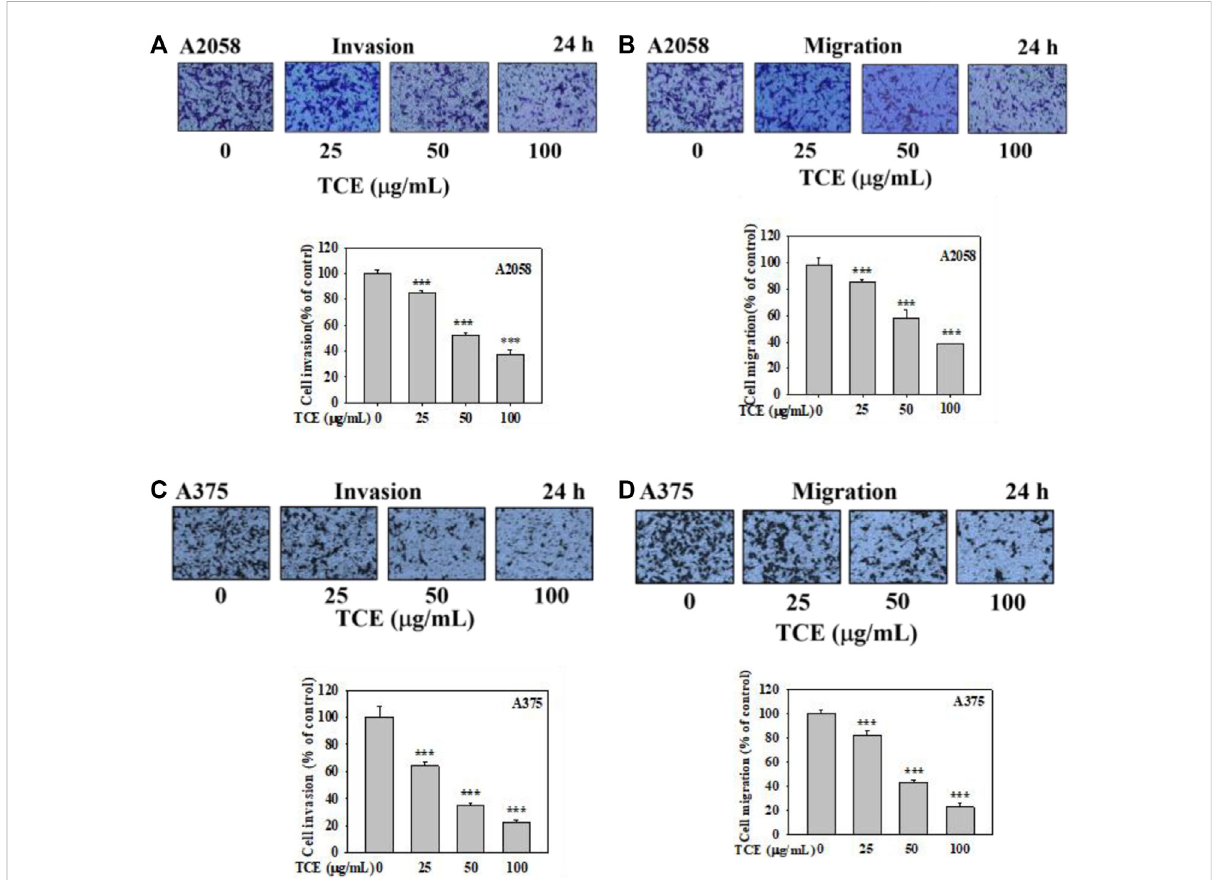
A375cellsonthelowersideofmembraneatdifferenttimepointsinthe (A,C) invasionand (B,D) migrationassay.Arepresentativenumberofinvading cells through the Matrigel and membrane were counted under the microscope for 10 random fi elds at a 3,200 magni fi cation. The results